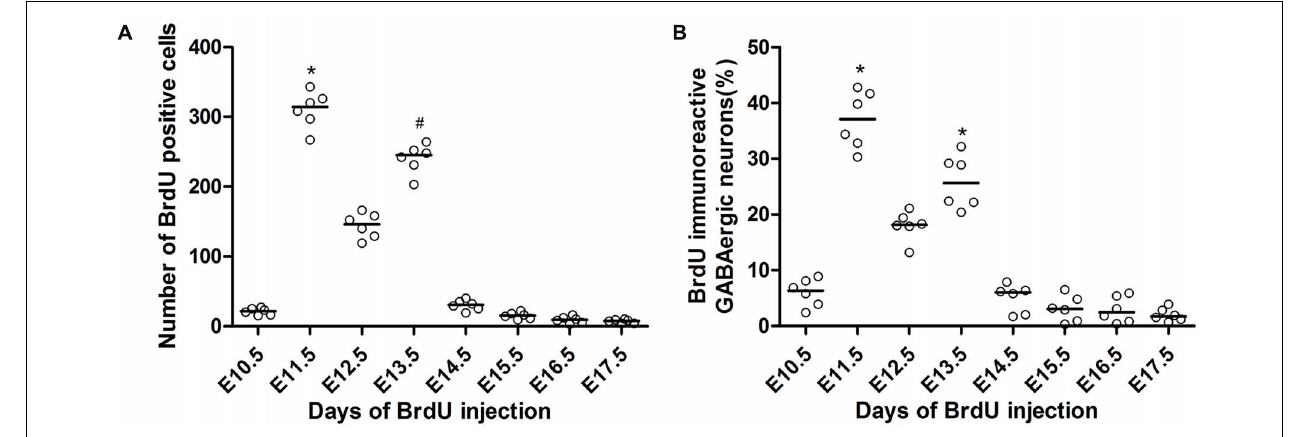
or the percentage of double-labeled cells among all GABAergic neurons, respectively.The horizontal bar indicates the median. Statistical differences were assessed by non-parametric method, namely Kruskal–Wallis test. * P < 0.05 compared with that of E10.5, E14.5, E15.5, E16.5, and E17.5. # P < 0.05 compared with that of E10.5, E15.5, E16.5, and